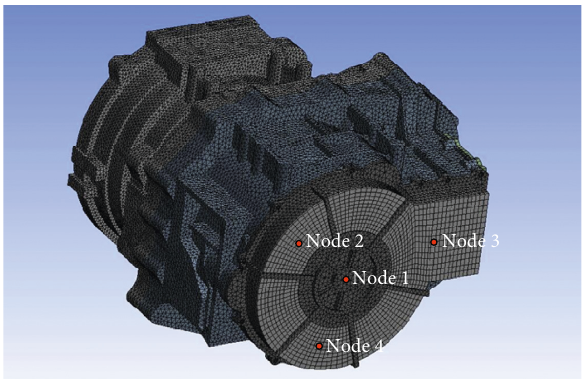
Figure 15: Locations of 4 typical